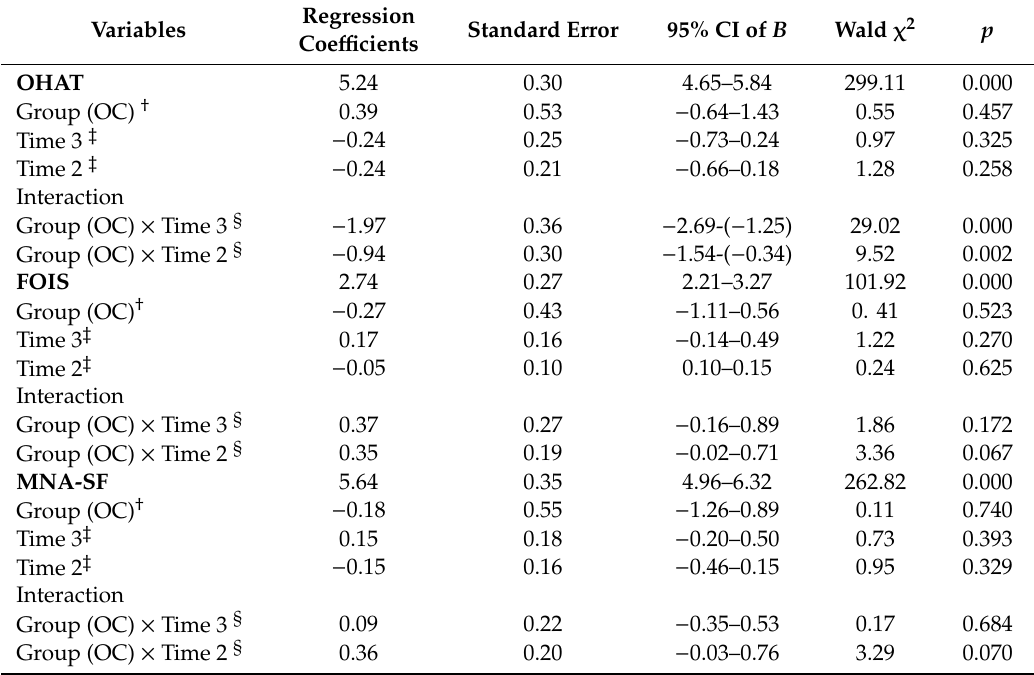
Table 3. Results of the Generalised Estimating Equation analysis on the e ff ectiveness of the oral health programme on the outcome variables.